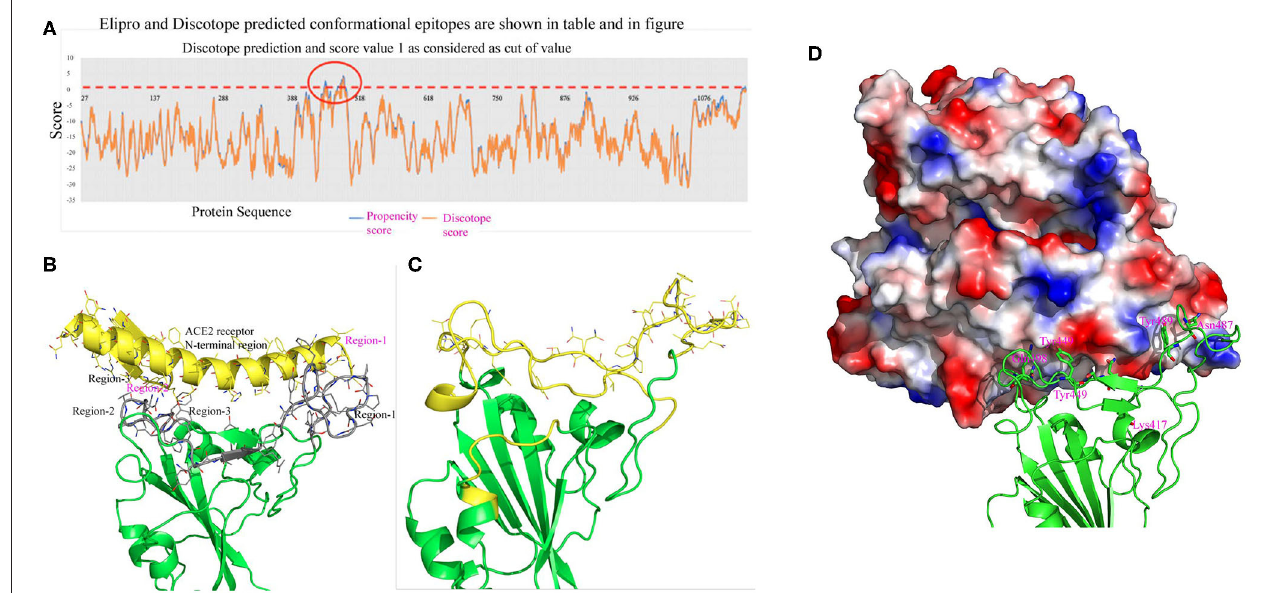
FIGURE 5 | (A) This figure shows conformational epitopes as predicted by Elipro, Discotope and SEPPIA-3. (B) Predicted ACE2 interacting regions are shown in gray color. The ACE2 receptor cartoon diagram is shown in yellow and binding regions are labeled in red. Interacting amino acids are shown as stick model. (C) Conformational epitope as predicted by SEPIa-3 is shown in yellow color. (D) The ACE2 receptor is shown in a surface diagram, which has a bowl-shaped surface to accommodate loop regions of the RBD. Residues shown in red are predictive antigenic epitope and this region is shown in cartoon diagram by yellow color.